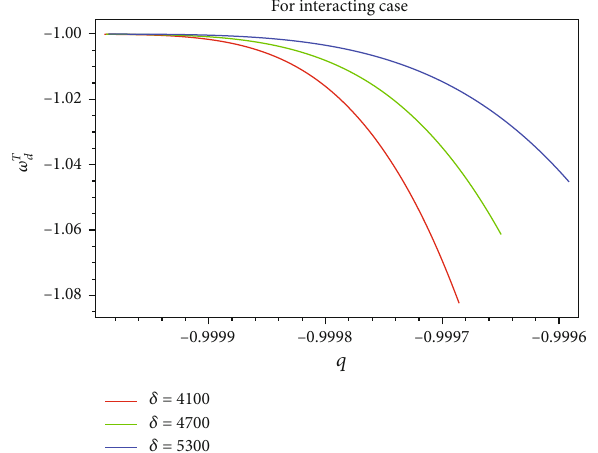
/ Ω T against m d